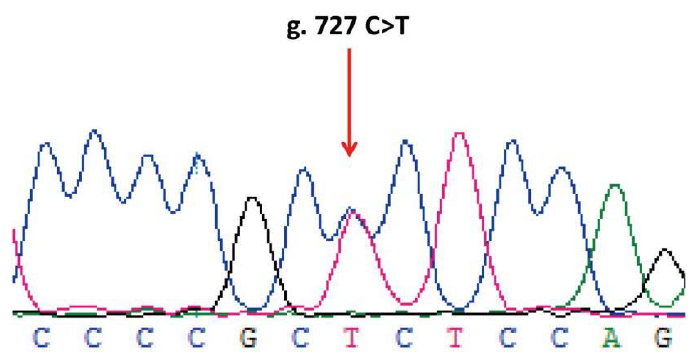
Figure 6. Sequencing results of the ovine LH β gene. The red arrow indicates the mutant peaks.